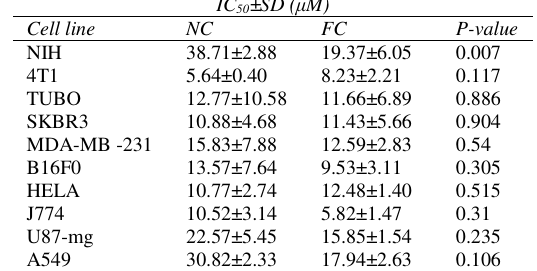
NC : curcuminoids nanomicelle, FC : free curcuminoids S tatistically Significant: P-value <0.05